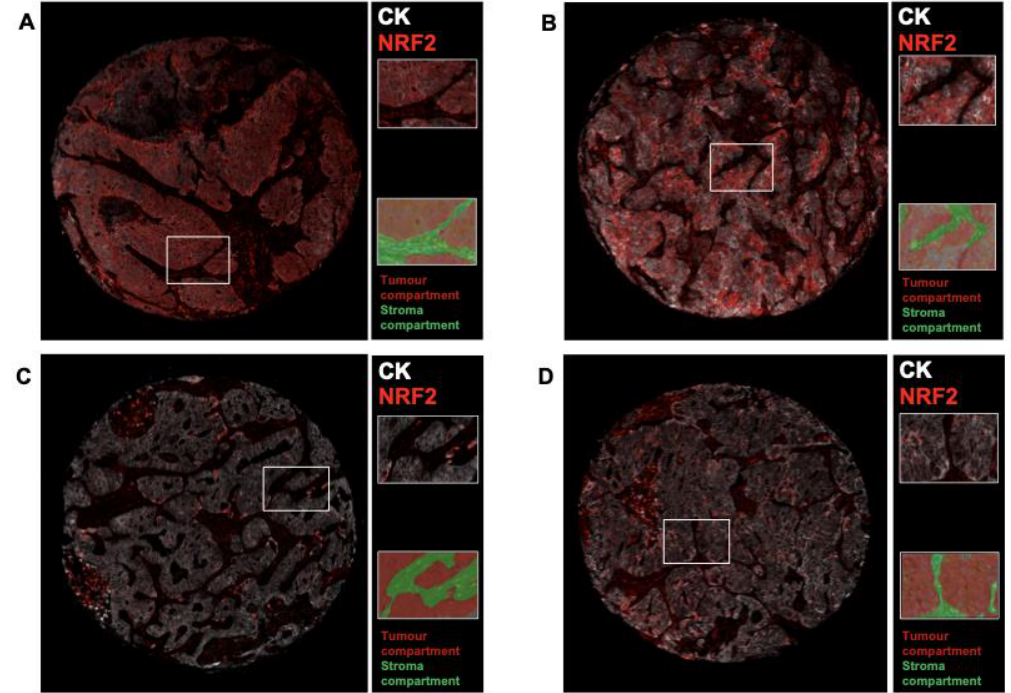
Figure 1. Representative multiplex immunofluorescence images from whole-tissue core biopsies of two patients with lung adenocarcinoma with a high ( A,B ) and low ( C , D ) density of cells stained positive for both CK (white) and NRF2 (red). Each tissue core includes zoomed-in images of the corresponding regions marked in the solid white box and a tissue segmentation map of tumor epithelial (red) and stroma (green) areas. Images were taken at 20× magnification (0.5 µm/pixel). Table 2. Cross-tabs: correlation between NRF2+/CK+ cell density and risk of CNS relapse.